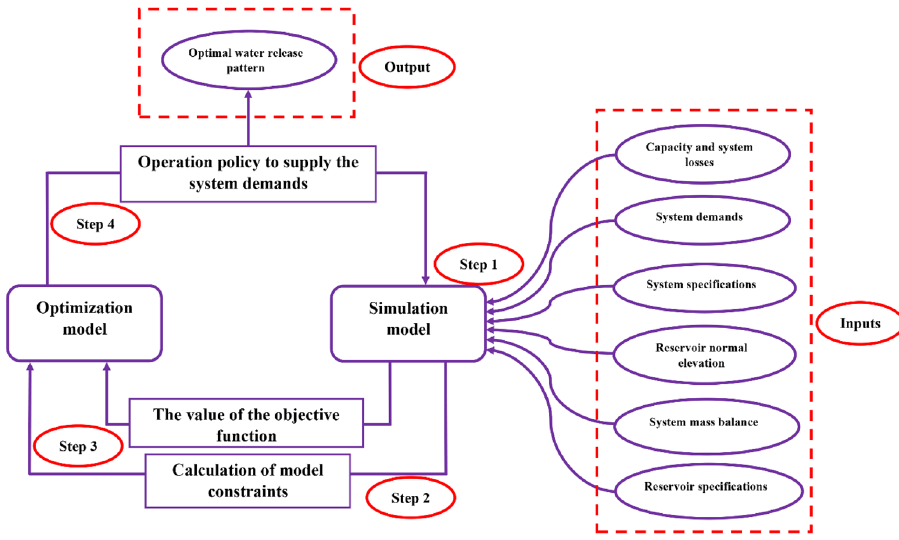
Figure 8. Conceptual model of simulation–optimization of operation of Halilrood reservoir